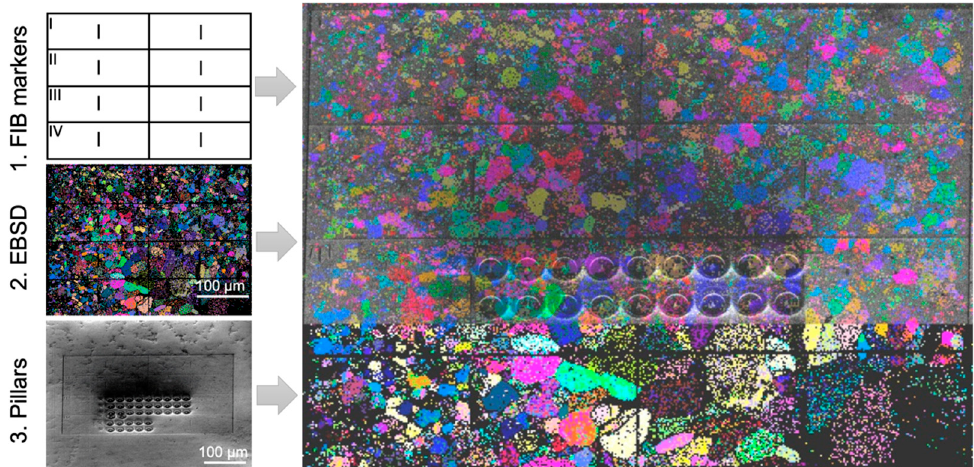
Figure 2. FIB-milled grid to enable correlation and alignment for nanomechanical testing in a Nb 2 Co 7 intermetallic sample. The sample was arc-melted and subsequently heat treated for 1000 h at 1000 °C, followed by mechanical polishing and a final colloidal silica polishing step. Image reproduced in part from [36] .